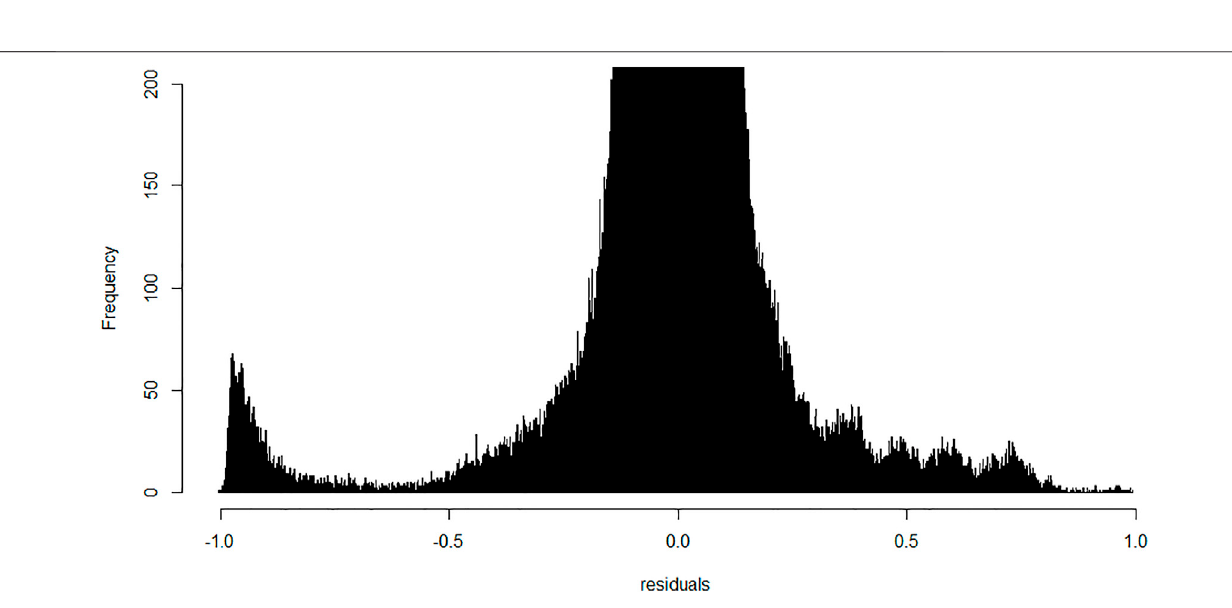
Frontiers in Bioengineering and Biotechnology |